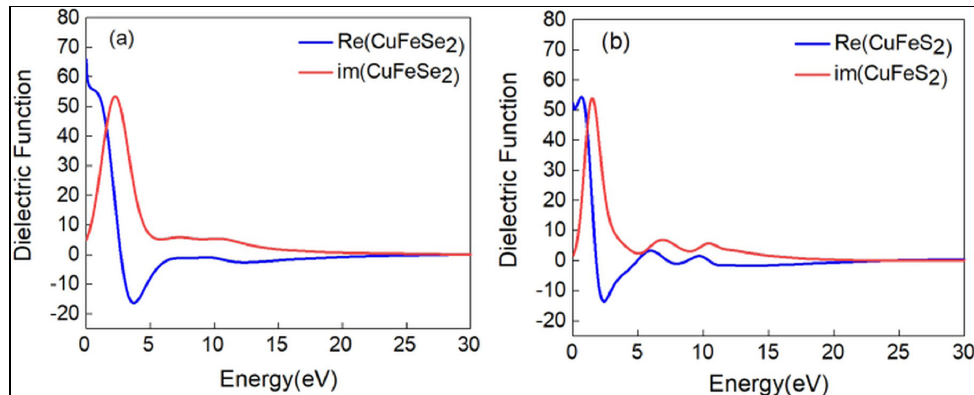
Figure 8. The real and imaginary parts of the complex dielectric functions of (a) CuFeSe